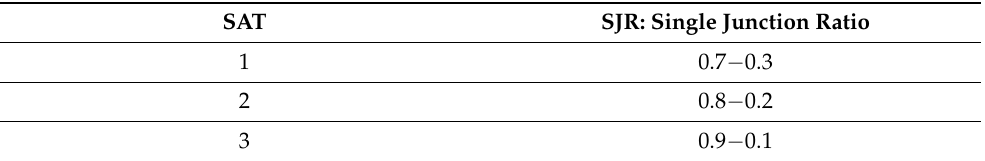
Table 1. Unbalance obtained between the two channels of the soliton neuron after 20 iterations of the mathematical model as a function of the SAT